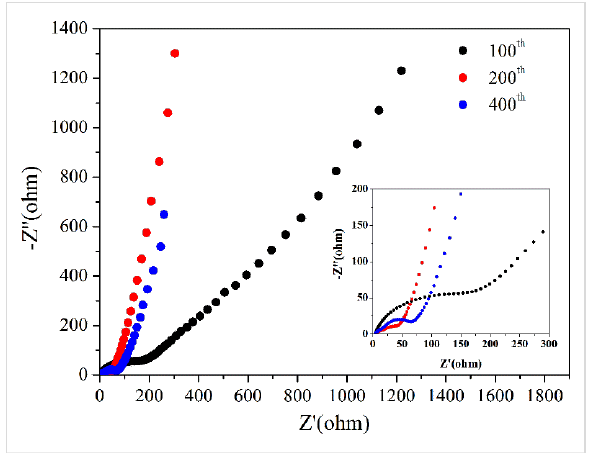
Figure 6: Nyquist plots of Fe 2 O 3 /COOH-MWCNT composite elec- trodes after 100, 200 and 400 discharge–charge cycles at a current density of 500 mA·g − 1